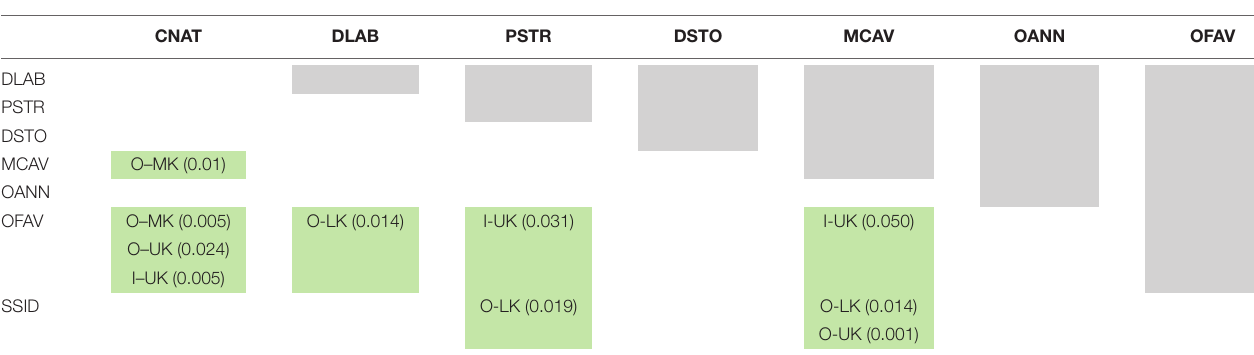
TABLE 7 | Tukey-adjusted pairwise comparisons ( p-values ) of “no active disease” (NAD) rates among amoxicillin-treated colonies of eight coral species by region.